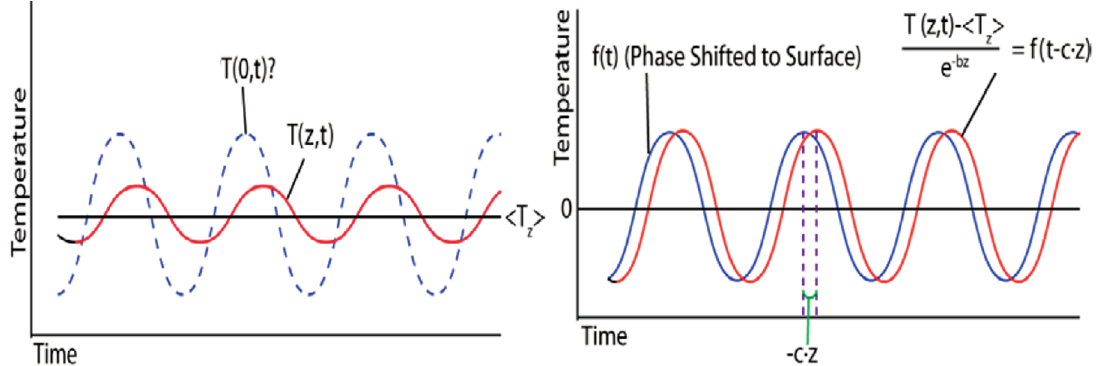
Figure 2. Graphic representation of the unknown diurnal surface temperature at time t ( left ), and the Zeng empirical correction method ( right